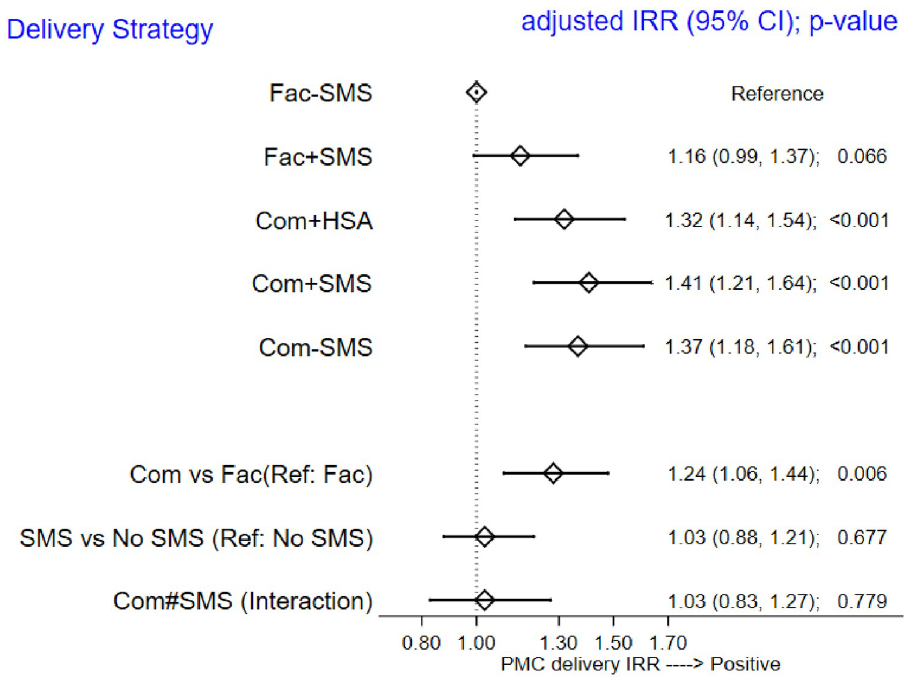
Fig 4. Forest plots illustrating adherence to PMC in each trial arm.